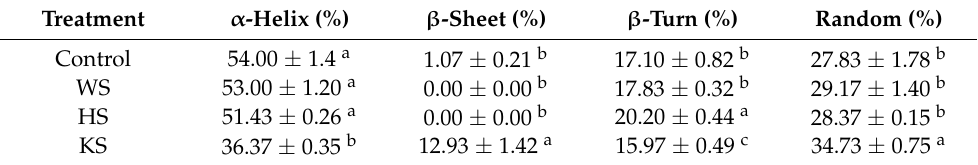
Table 3. Relative contents of secondary structural elements in surimi protein.